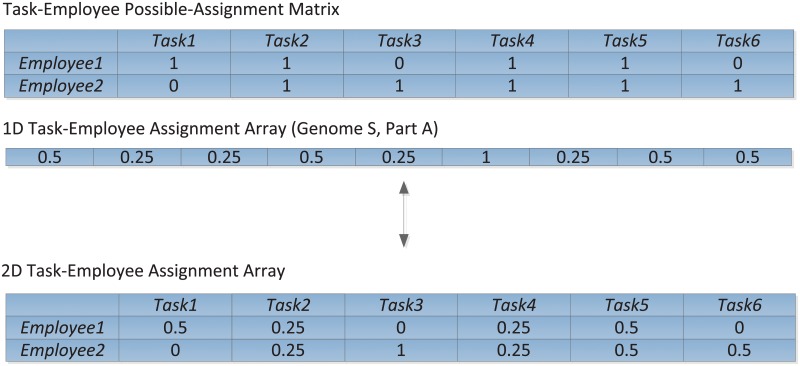
Part A of Genome S Generated from Possible-Assignment Matrix and 2D Task-Employee Assignment Array.